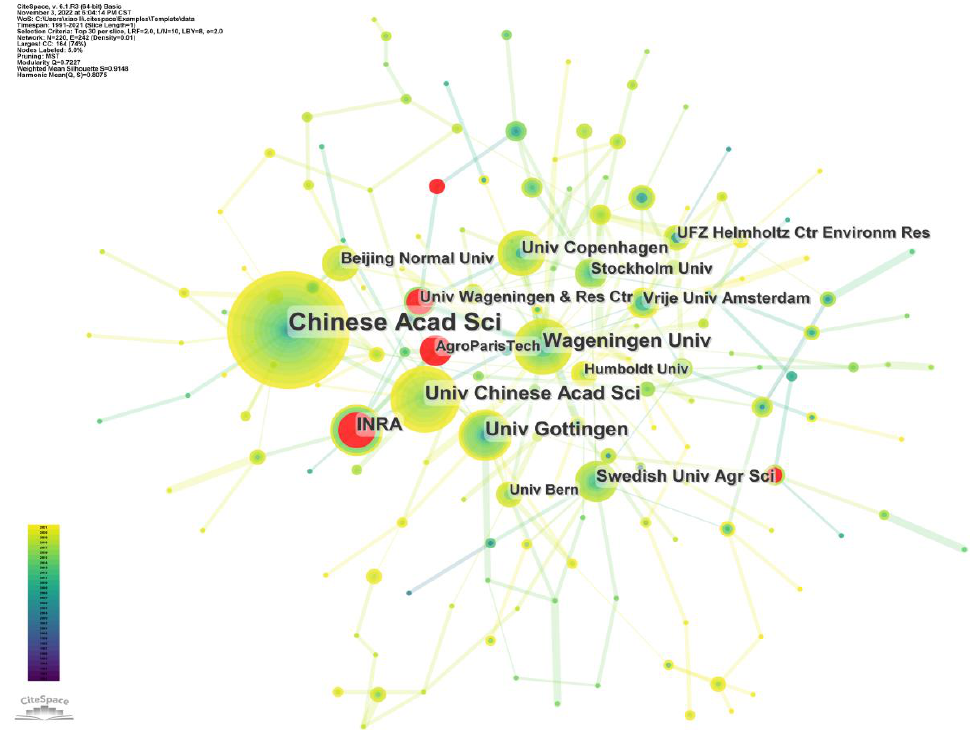
Figure 2. Co-occurrence networks of the top 30 institutions with publications (the legend represents the color display for each year from 1991 to 2021).